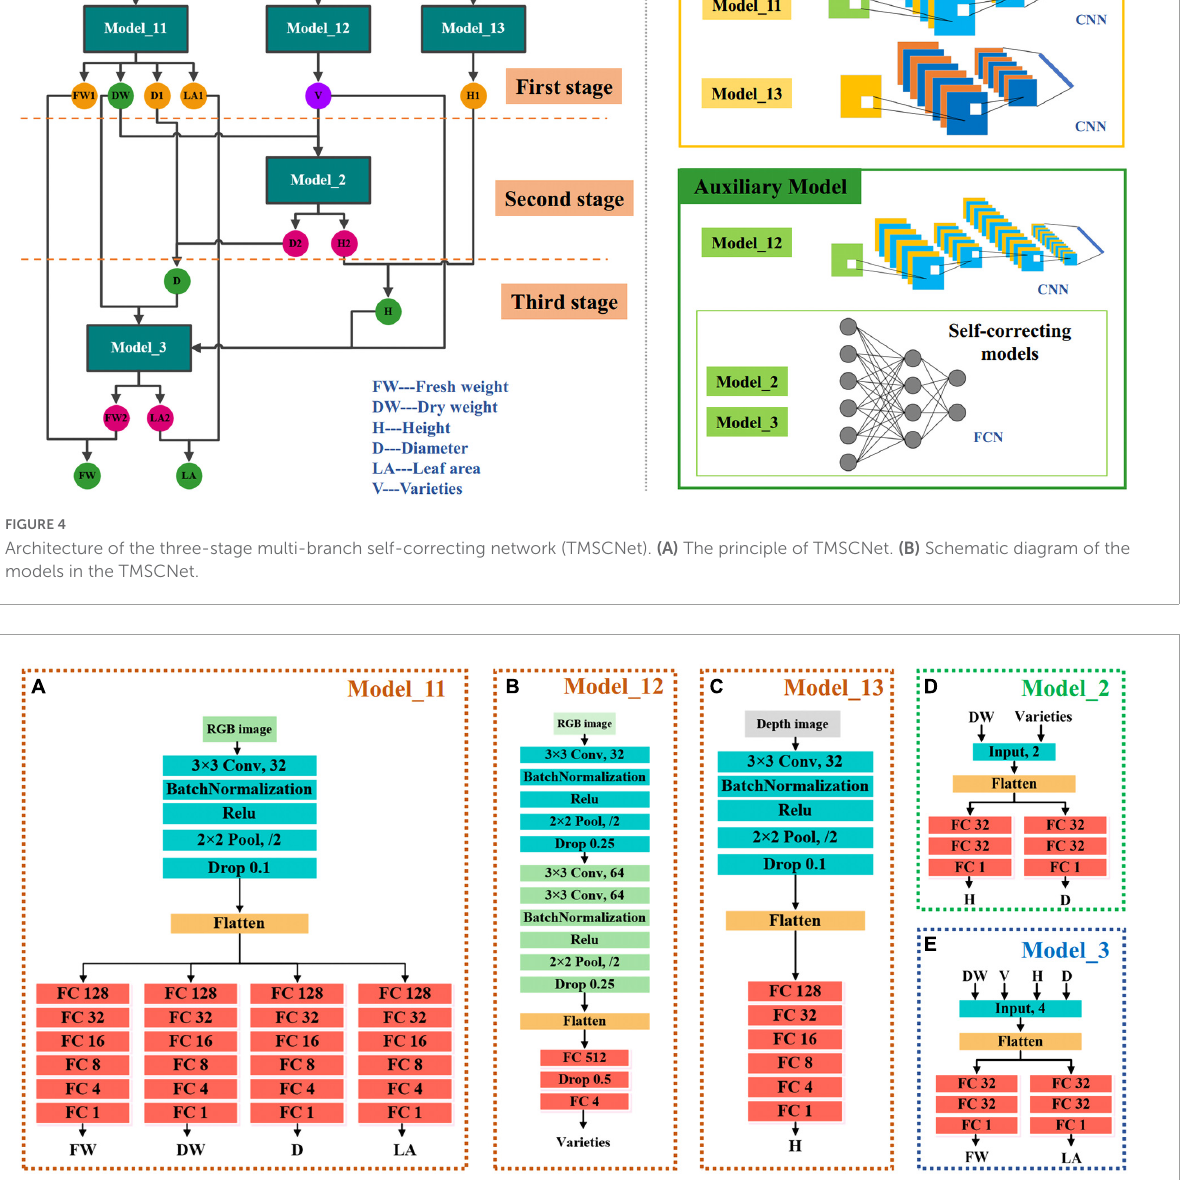
had the same structure and parameter settings as Model_2. Its inputs were DW, H, D, and lettuce varieties, and its outputs were estimated values of FW and LA.